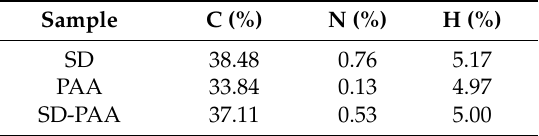
Table 1. Elemental analysis of soybean dregs (SD), Poly(acrylic acid) (PAA), and SD-PAA. Sample